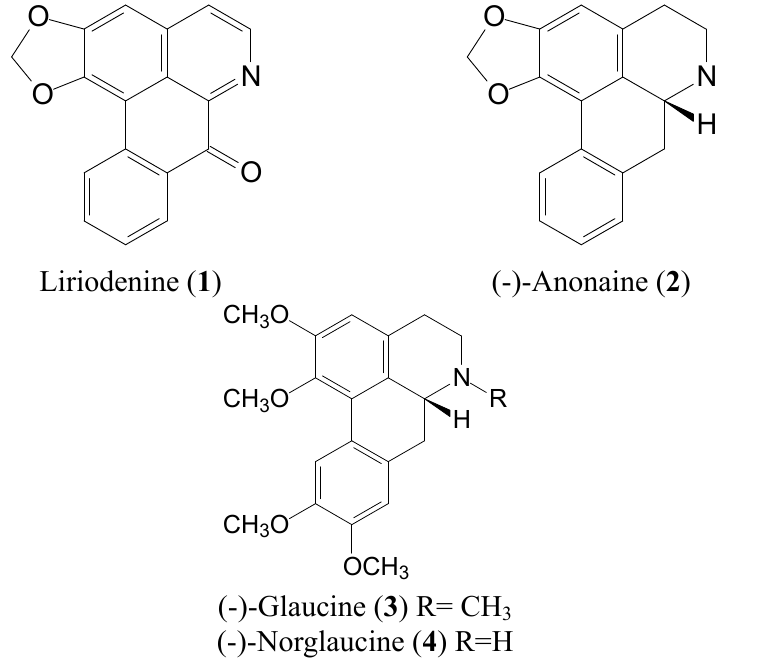
Figure 1. The chemical structures of compounds 1 − 4 from the stems of L. tulipifera